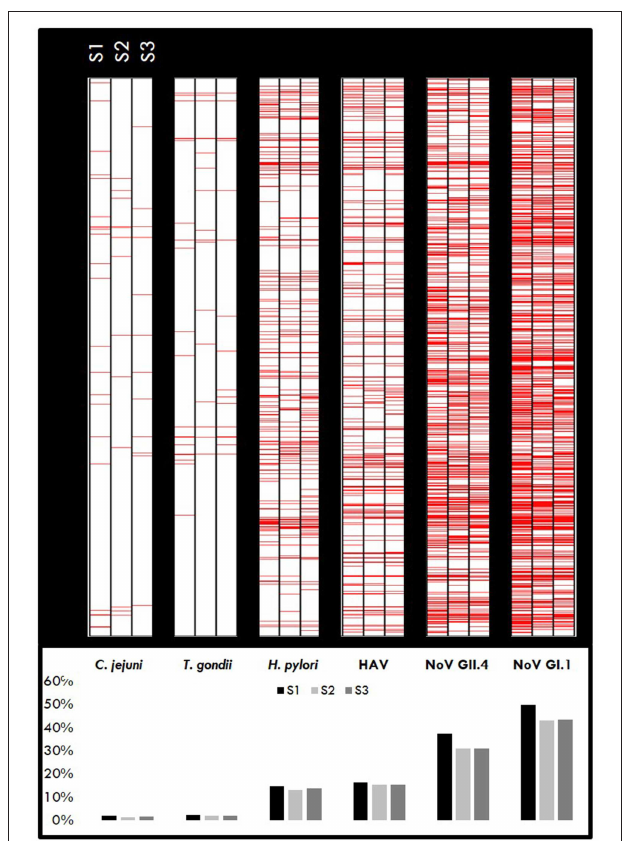
FIGURE 2 | Immunopositivity heatmaps showing MFI response by pathogen for individuals who gave all three samples ( n = 1,399). Upper panel: Red lines represent positive samples ( ≥ cut-off) for S1, S2, and S3 samples for each pathogen. The darker areas indicate a higher number of positive samples. Lower panel: Percentage of samples positive for each pathogen.